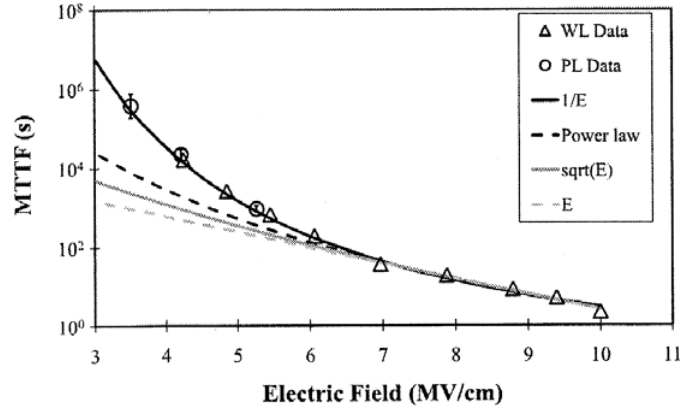
Figure 6. Experimental validation of four proposed dielectric reliability models using /Si capacitors. Reprinted with permission from reference [55]. Copyright (2011) by Cu/SiO 2 the American Institute of